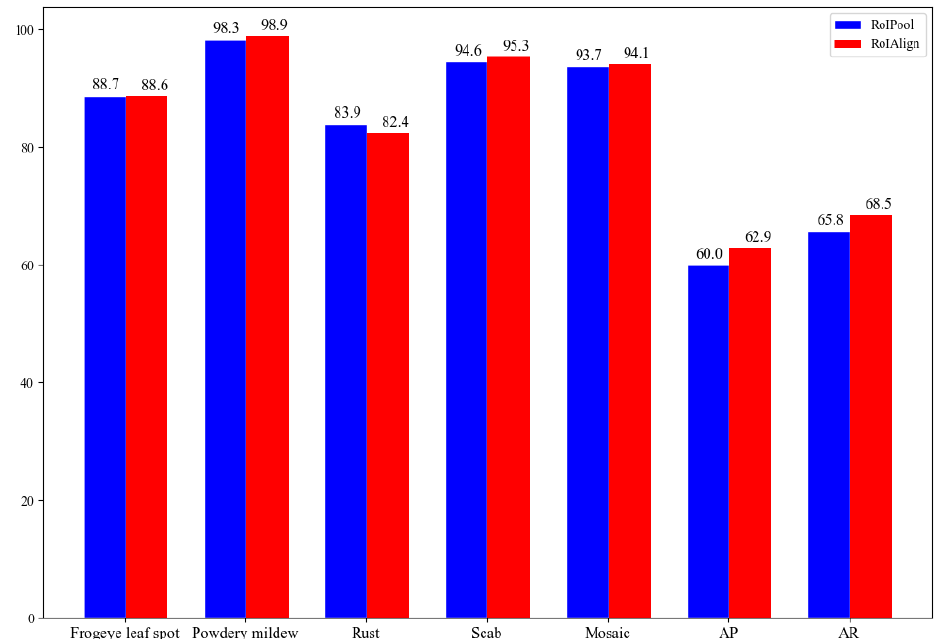
Figure 6. The indictors comparison of apple leaf diseases detection using RoIPool and RoIAlign. AP and AR denote average precision and average recall, respectively. (unit: %).